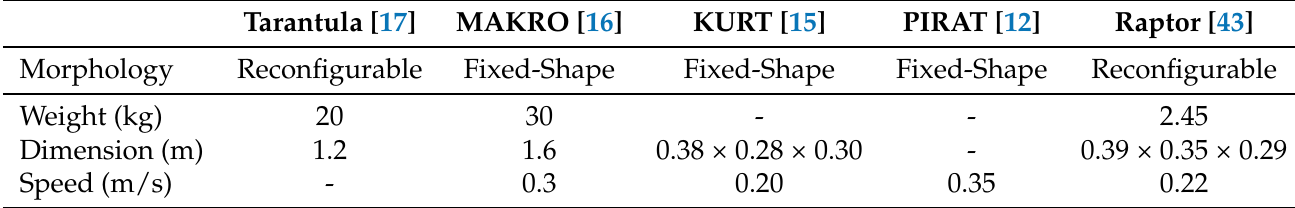
Table 7. Comparison with existing drain inspection